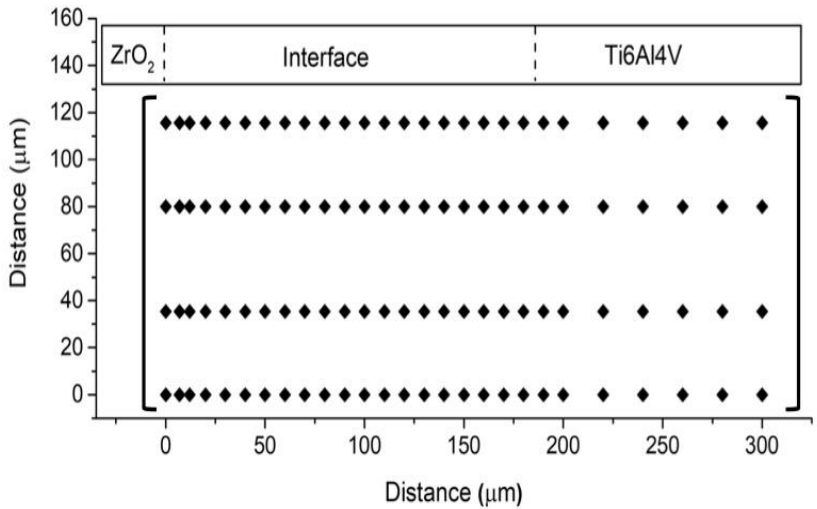
Figure 1. The matrix for the Vickers microhardness test showing the indentation position ( (cid:7) ) across the joint interface.